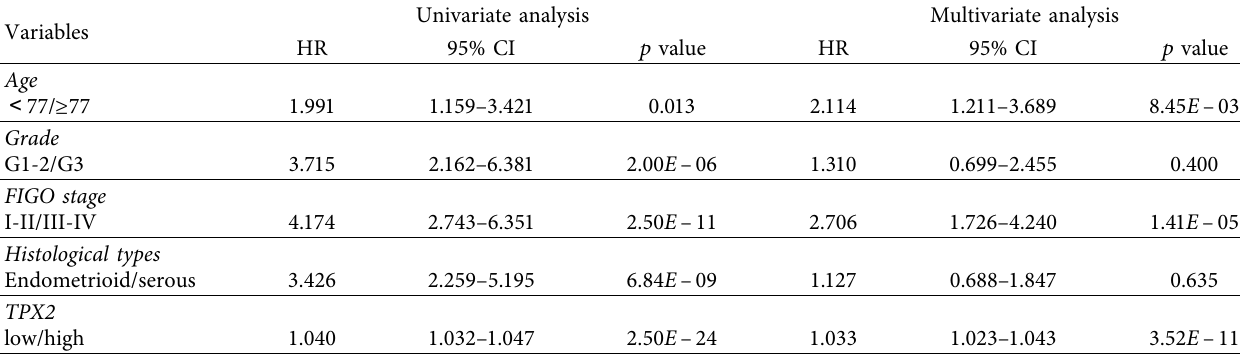
Table 2: Univariate/multivariate cox regression analysis for independent prognostic